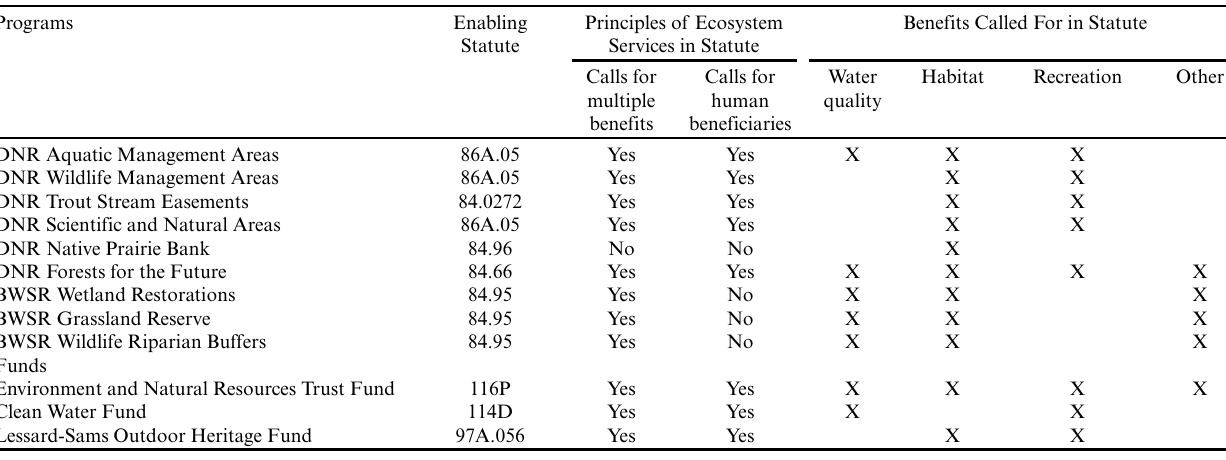
Table 1 . Principles of ecosystem services and specific benefits called for in conservation program and conservation fund enabling statutes. The enabling statutes for programs reviewed broadly supported an ecosystem services-based approach even though the phrase “ecosystem services” was not used. The benefits called for in the statute were typically water quality, habitat, and recreation. The “Other” category includes flood mitigation, carbon storage, scenic services, timber production, and air and land quality. With the exception of DNR’s Native Prairie Bank, the enabling statutes for all programs or funds called for multiple